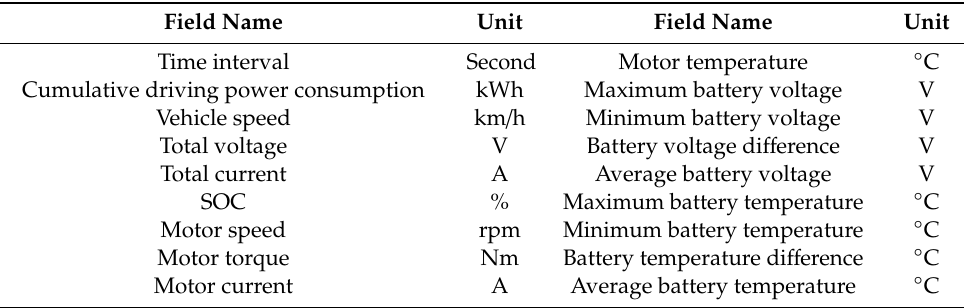
Table 1. Format of the data collected by the